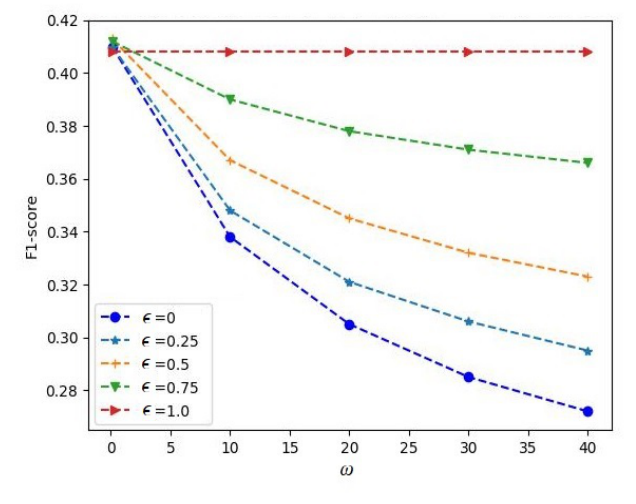
Figure 7. F1-score measures as functions of the softmax hyperparameter ω for different contamination parameters (cid:101) and for the Normal dataset.